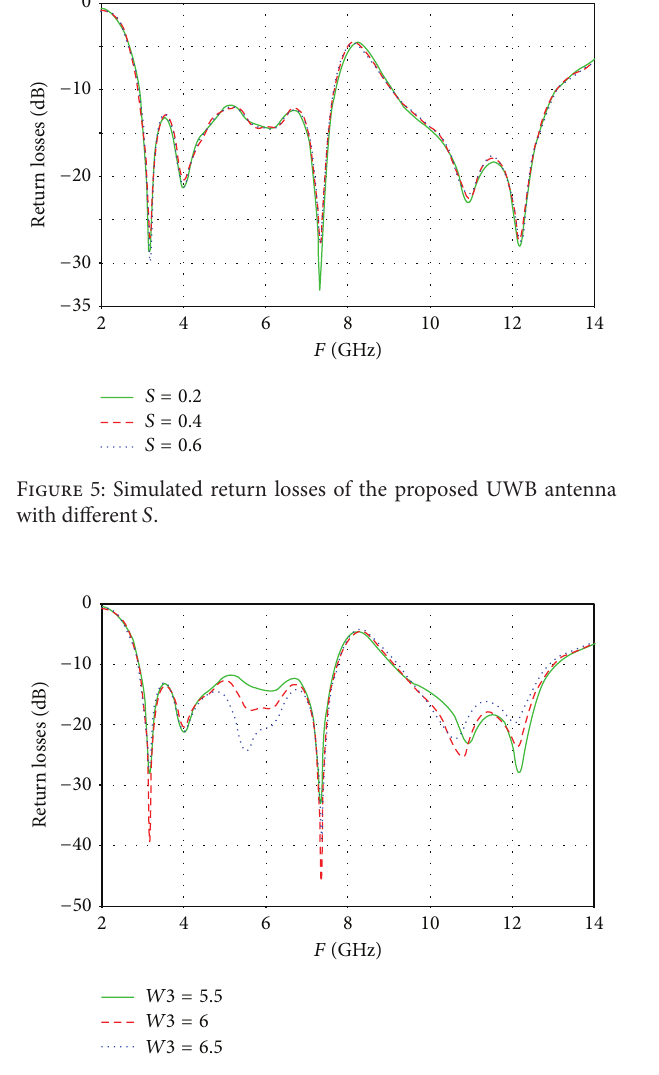
Figure 6: Simulated return losses of the proposed UWB antenna with different 𝑊3 .